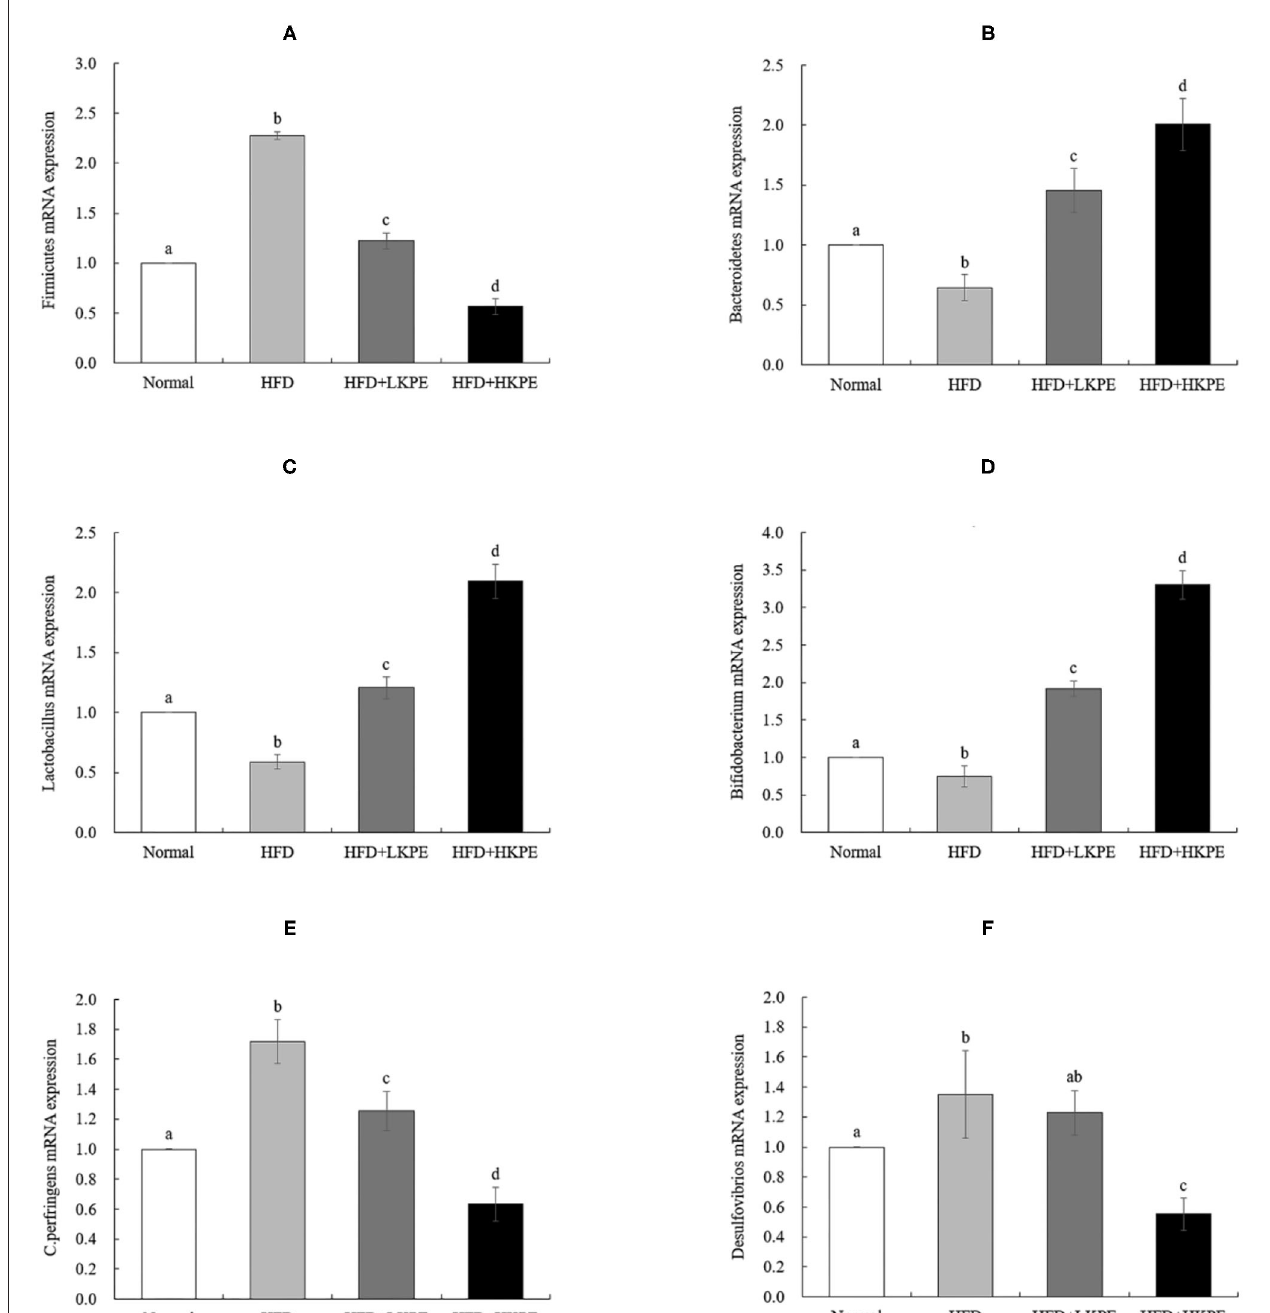
FIGURE 4 | KPE supplementation stimulates the expression of Bacteroidetes , Lactobacillus , and Bifidobacterium . The mRNA expression levels of Firmicutes (A) , Bacteroidetes (B) ; Lactobacillus (C) ; Bifidobacterium (D) ; C. perfringens (E) ; Desulfovibrios (F) . Different letters (a–d) are used to express the significant difference ( P < 0.05) of the same factor among